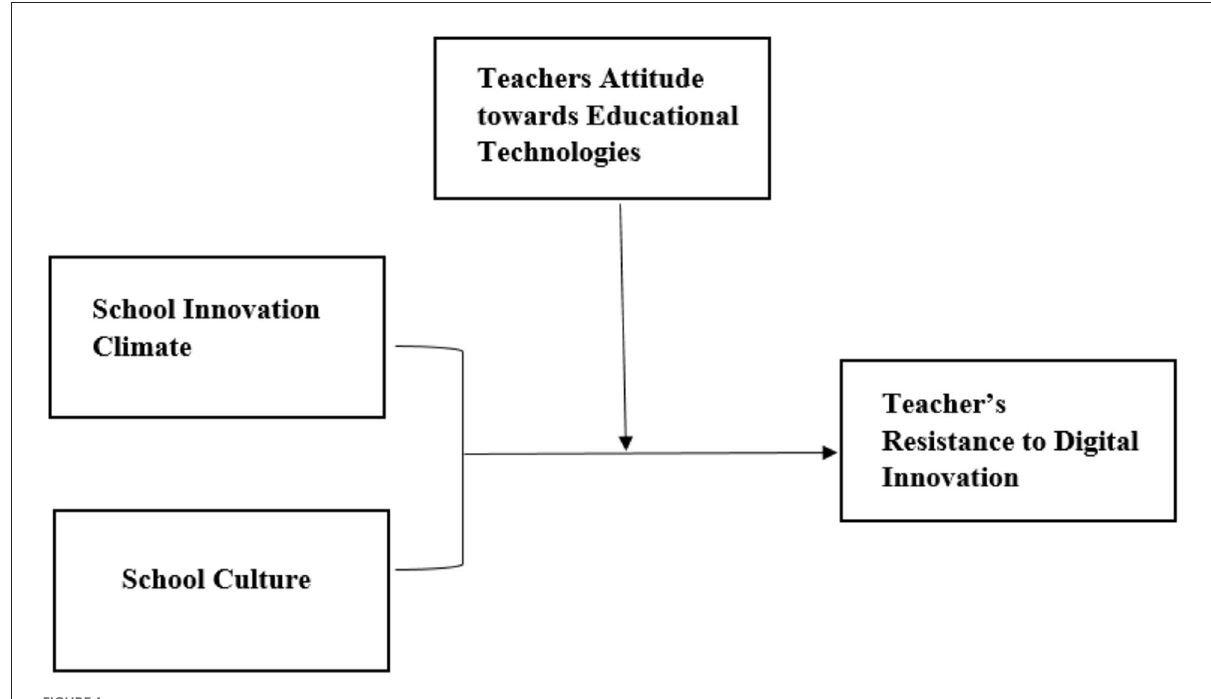
FIGURE1 Theoretical framework development.